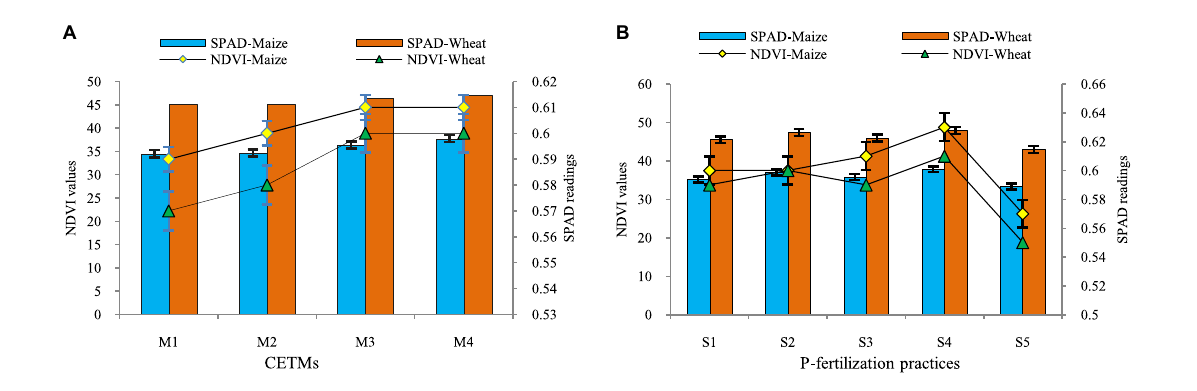
FIGURE2 Effect of crop establishment and tillage management (CETM) (A) and P-fertilization practices (B) on NDVI, SPAD at flowering stage of maize and wheat under MWCS. The vertical bars represent LSD 0 . 05 values . M 1 , flat bed–conventional tillage (FBCT) both in maize and wheat; M 2 , raised bed–CT (RBCT) in maize and RB–zero tillage (RBZT) in wheat; M 3 , FBZT both in maize and wheat; M 4 , permanent raised bed–ZT (PRBZT) both in maize and wheat. S 1 -P 100 , 100% P as basal; S 2 -P 50 + 2FSP, 50% P as basal (P 50 ) + 2 foliar sprays of phosphorus (2FSP) as DAP (2%) at knee-high stage (KHS) and pre-tasseling stage (PTS) in maize and at tillering stage (TS) and pre-flowering stage (PFS) in wheat; S 3 -P 50 + PSB + AM-fungi (AMF); S 4 -P 50 + PSB + AMF + 2 FSP at KHS and PTS in maize and at TS and PFS in wheat; S 5 -P 0 , 100% N and K with no-P (P 0 ) as